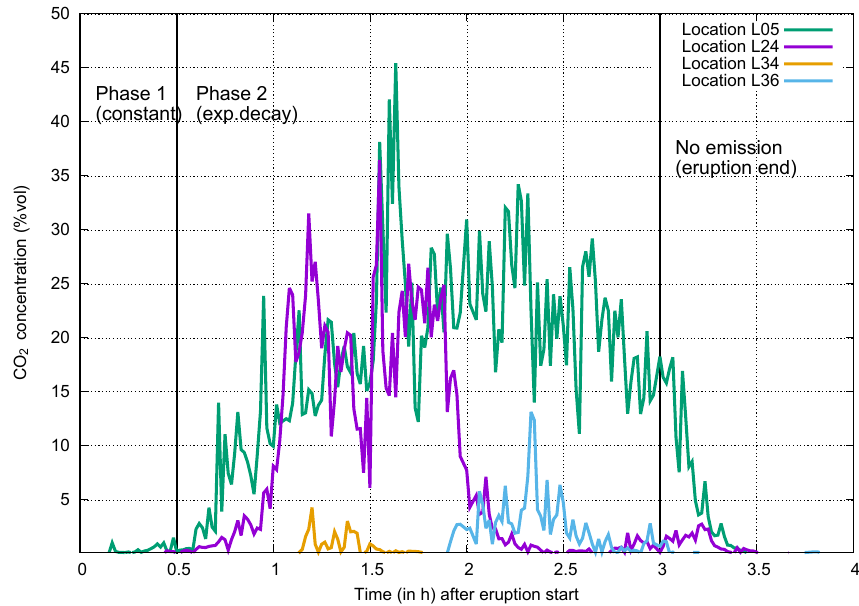
Figure 15. Evolution with time (in h) of CO 2 concentration (%vol.) at different locations for the best-fit simulation. Results at 1m height. Location L05 is near the Lake, L24 at the Nyos valley, L34 near Cha (W branch), and L36 near Subum (E branch). See Fig. 3 for